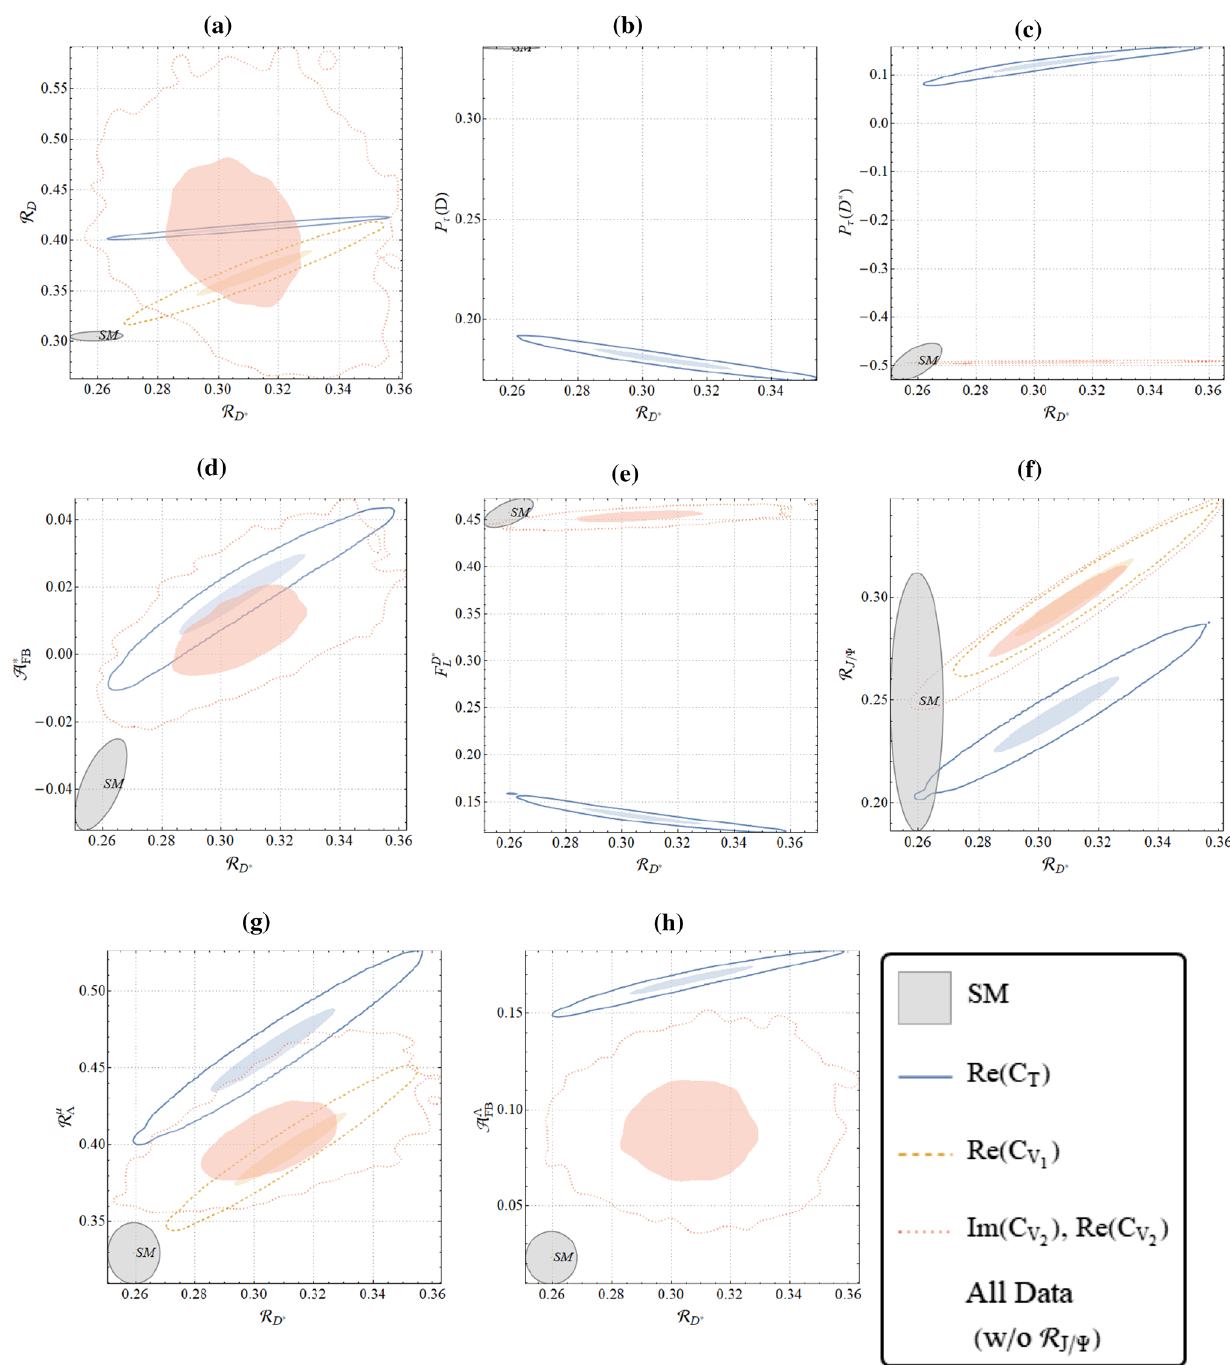
Fig. 3 Correlation plots among different observables for one-operator scenarios listed in the first column of Table 7. Blue (solid), orange(dashed), and red (dotted) contours correspond to the